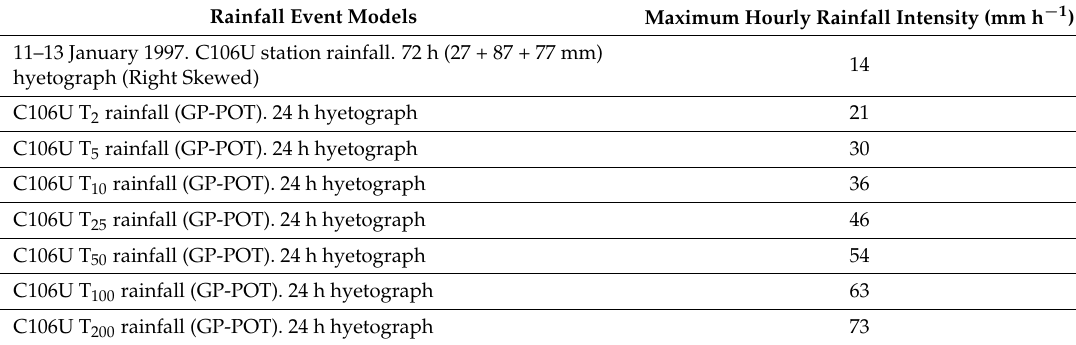
Table 2. Maximum hourly rainfall intensity used in hydrological modeling